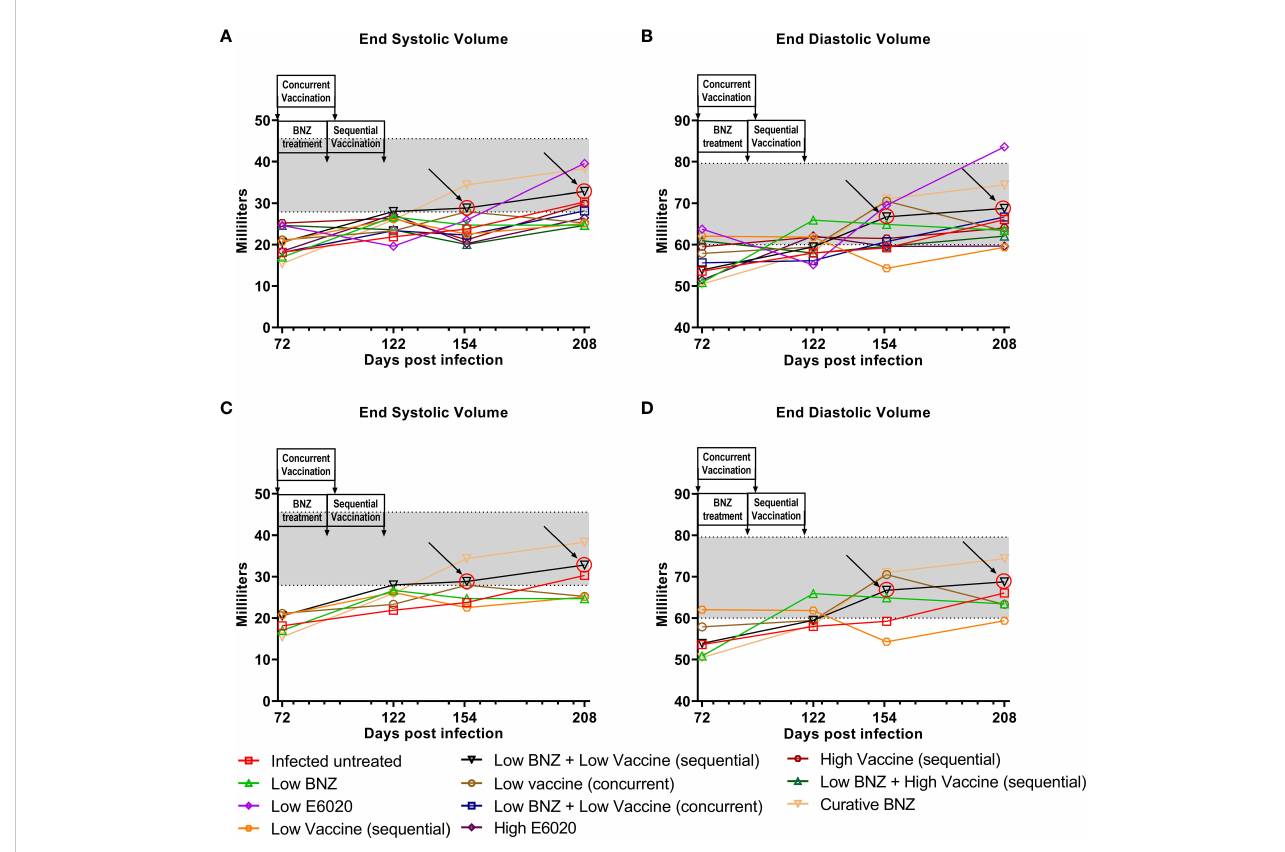
FIGURE 5 Left ventricular volume after treatment. M-mode images from echocardiographic examination were used to measure left ventricular volume (ESV and EDV) in naïve, infected untreated and treated mice at 70dpi, 122dpi, 154dpi and 208dpi during both systole (A) and diastole (B) . Panels (C) and (D) illustrate only a subset of treatment groups to better visualize treatment differences between key groups. The grey shaded area represents the mean ± SD of the ESV and EDV measurement from naïve age matched